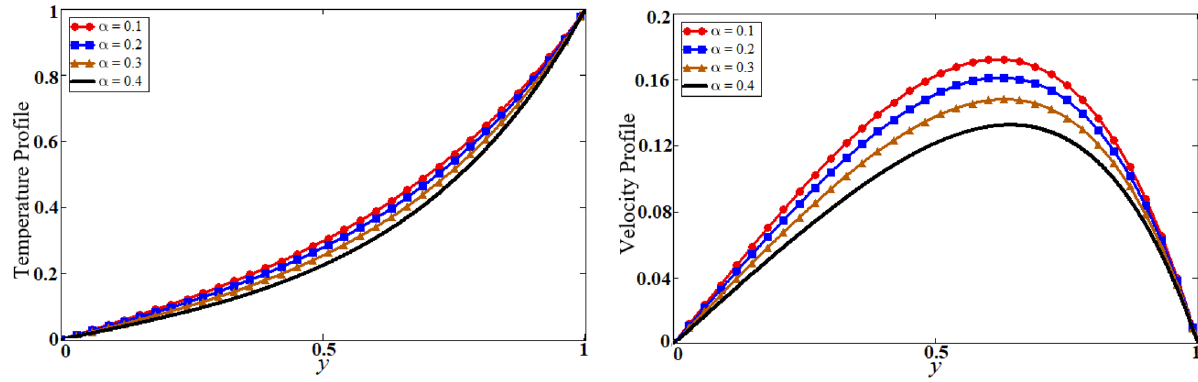
Figure 4. Results of the fractional parameter α on temperature and velocity profile.